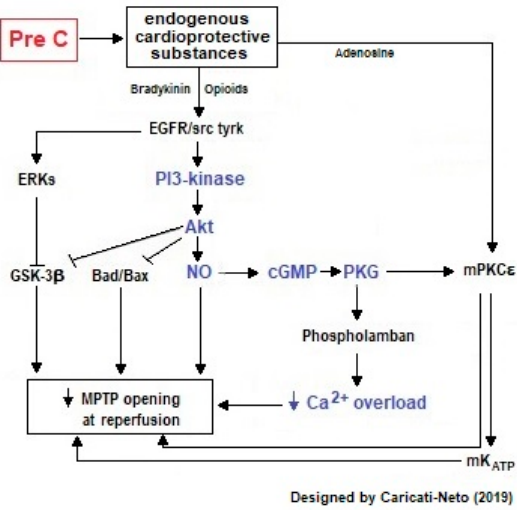
Figure 3. Intracellular signaling involved in cardioprotective response stimulated by